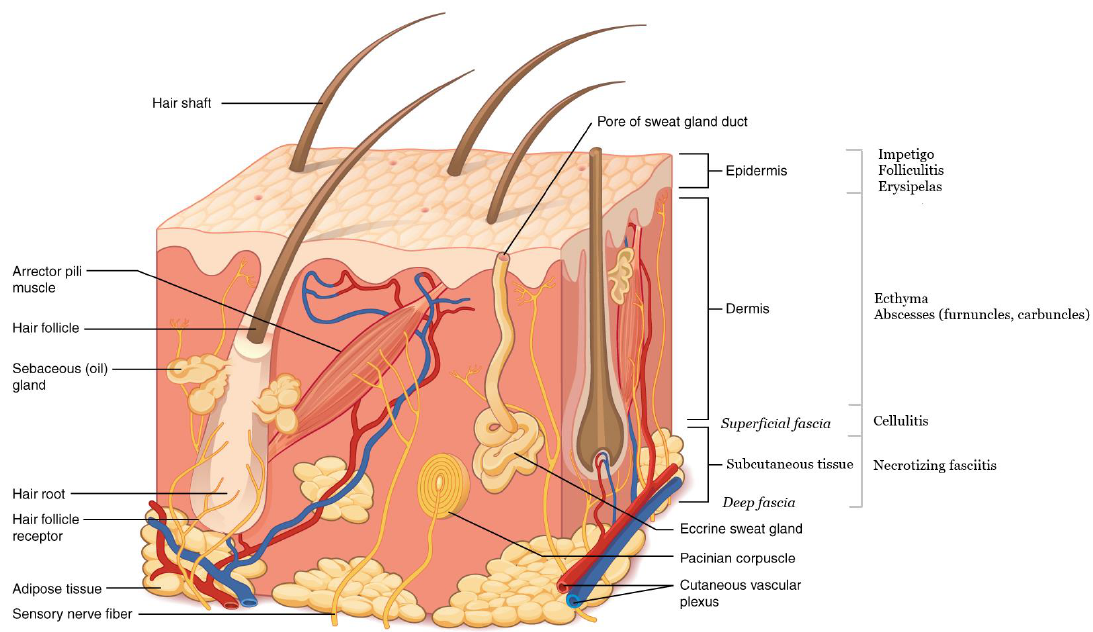
Figure 1. Infectious processes by depth. Soft tissue structures and layers of the skin are also marked (adapted from Figure 5.2 of Anatomy and Physiology, 2013, via OpenStax College; licensed through Creative Commons – https://commons.wikimedia.org/wiki/File:501_Structure_of_the_skin.jpg). A third way to classify SSTIs is whether they are suppurative (pus-forming) or not [1,3,14]. Localized purulent staphylococcal infections result in the formation of furuncles (boils), carbuncles